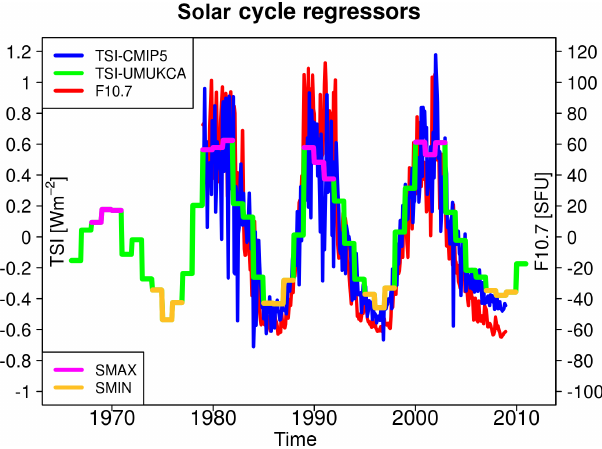
Figure 1. Time series of anomalies in TSI (Wm − 2 ) from the orig- inal CMIP5 recommendations (blue; http://solarisheppa.geomar. de/cmip5, last access: 16 April 2015; Fröhlich and Lean, 1998; Lean, 2000; Wang et al., 2005; Lean, 2009), TSI (Wm − 2 ) as given by the processed CMIP5 recommendations imposed in UM- UKCA (green; Fröhlich and Lean, 1998; Lean, 2000; Wang et al., 2005; Lean, 2009; Jones et al., 2011) and the F10.7cm radio flux (SFU) (red; http://lasp.colorado.edu/lisird/tss/noaa_radio_flux. html, last access: 30 April 2015). SMAX and SMIN years used in the composite methodology are highlighted in magenta and yellow,